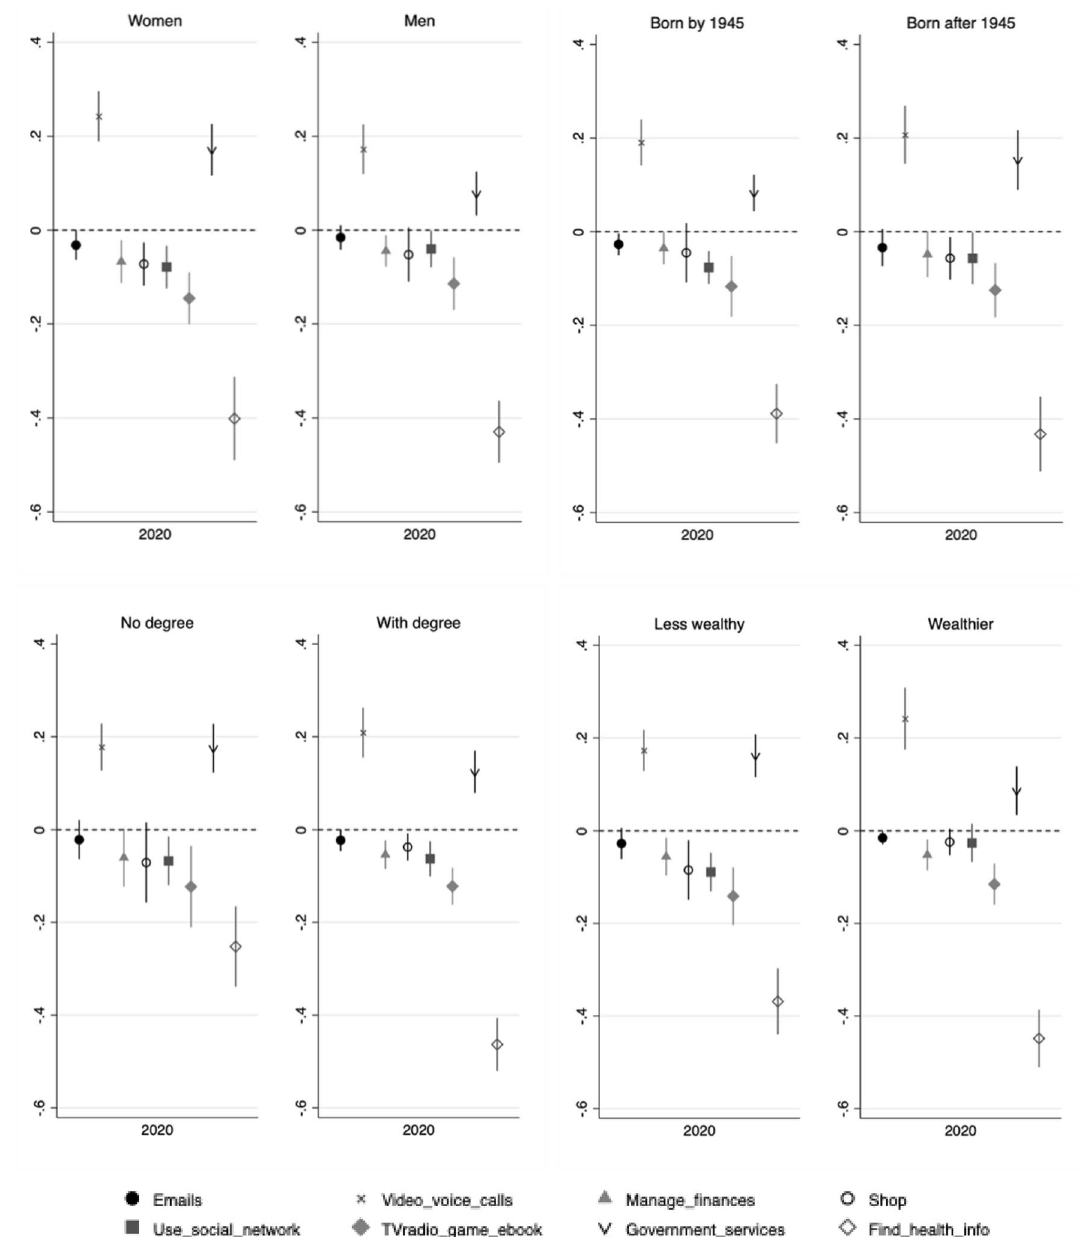
Figure 5. Within-individual changes from 2018/2019 in types of Internet use, by gender, cohort, education, and wealth levels. Estimates are from individual fixed-effects regressions, which include controls for the following observed time-varying covariates: age, partnership and employment status, perceived financial difficulties, self- reported health, depressive symptomology, loneliness, levels of positive and negative support from partner, and contact with others. All regression outputs are in Supplementary Table